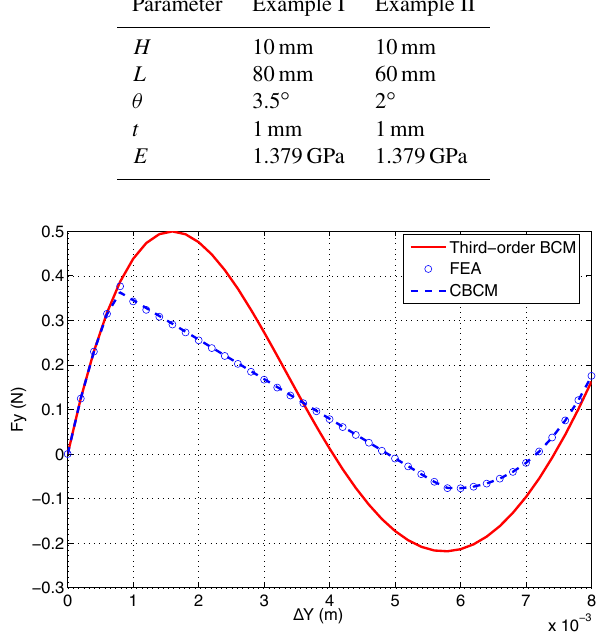
Figure 9. Comparison of the load-displacement relationship of Ex- ample I.